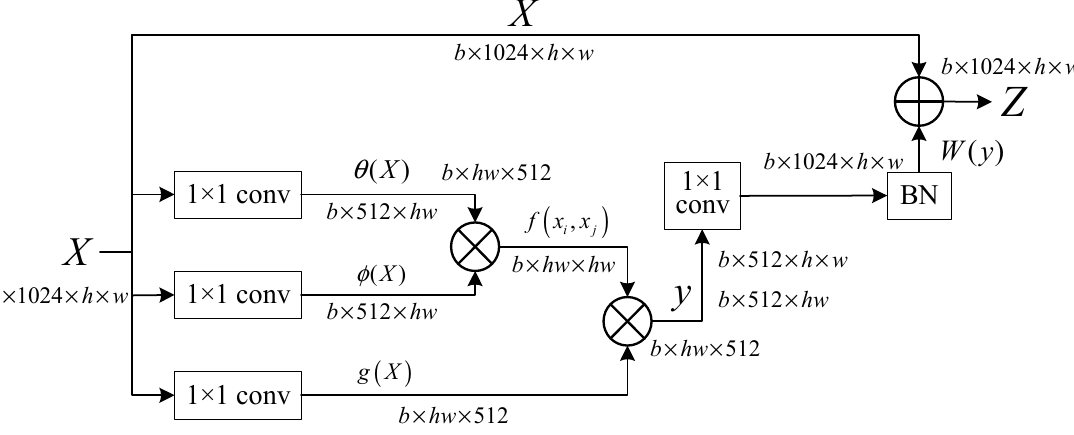
Figure 3. The component of the non-local attention block.